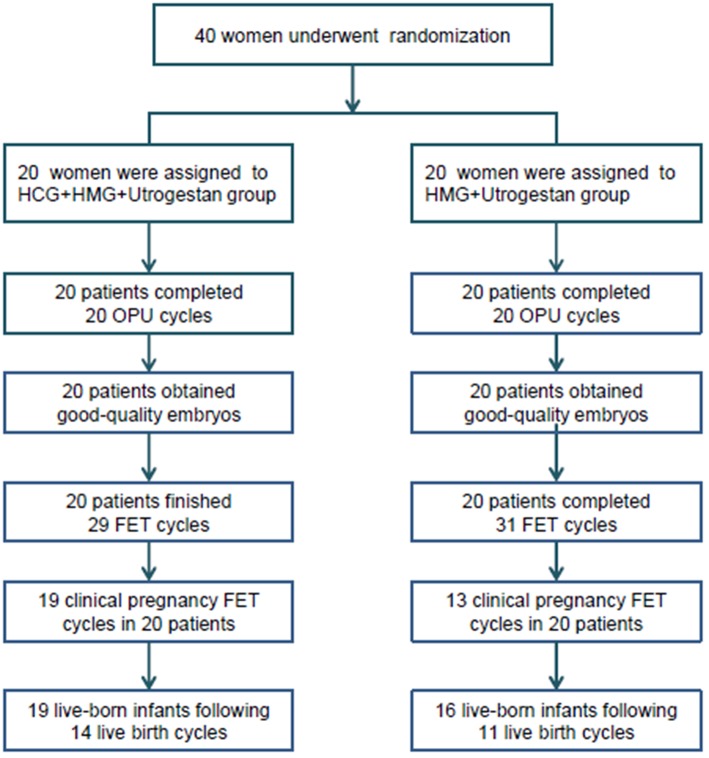
Flowchart of the study. OPU, oocytes pick-up; FET, frozen-thawed embryo transfer; HCG, human chorionic gonadotropin; HMG, human menopausal gonadotropin.